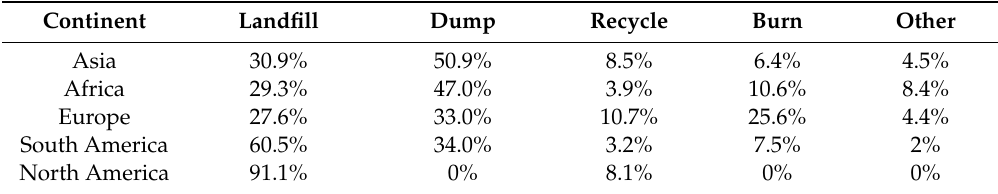
Table 1. Solid waste disposal methods per continent. According to the Global Development Research Center